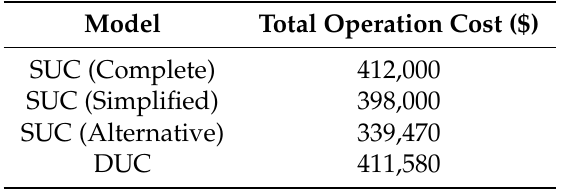
Table 1. 15-min time period—total operating costs for different UC